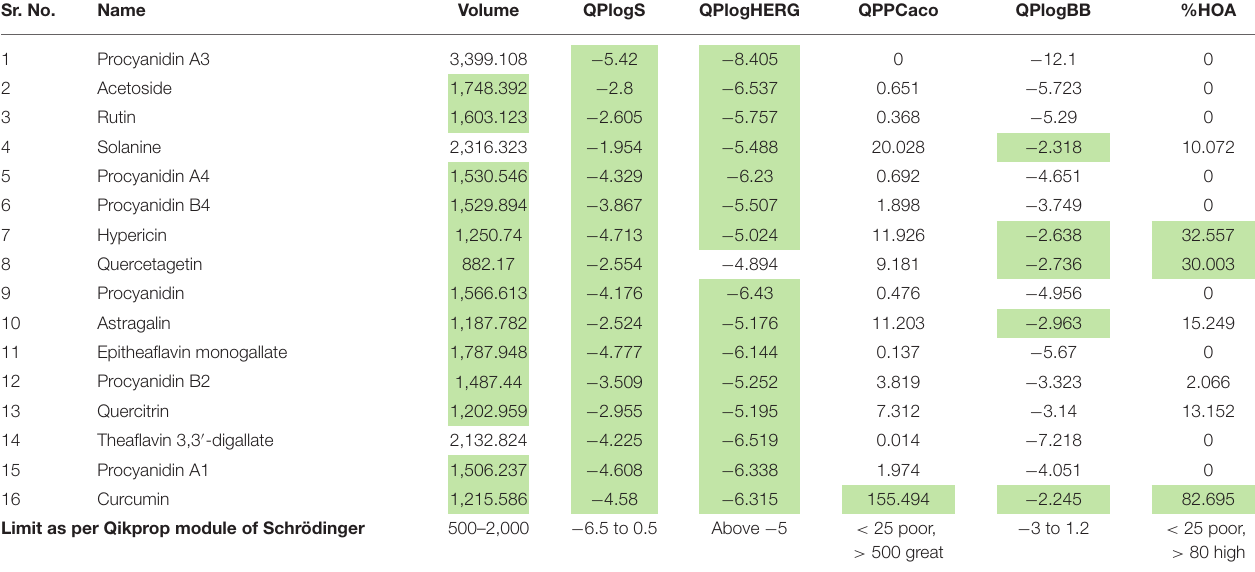
TABLE 4 | Predicted pharmacokinetic parameters of phytoconstituents a . Sr.